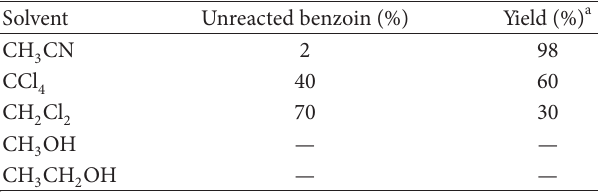
T 2: e effect of solvent on the yield of reaction at room